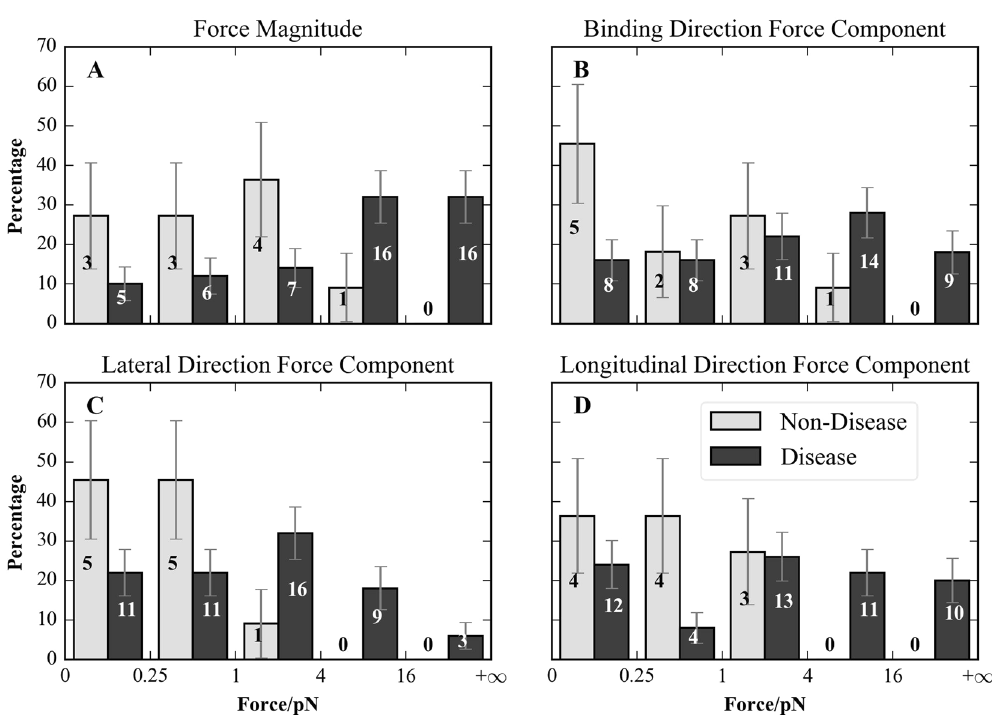
Figure 4. Whether a mutation causes a disease or not is correlated to the electrostatic force differences. Normalized histograms of disease-causing (black) and non-disease-causing (gray) mutations by electrostatic force difference when kinesin is in the unbound state for ( A ) ∆ F , ( B ) Δ F bind , ( C ) Δ F lat , and ( D ) Δ F long . Total mutation counts are labeled on each bar. Note that our dataset included a total of 50 disease-causing mutants and 11 non-disease-causing mutants. The error bars indicate the standard